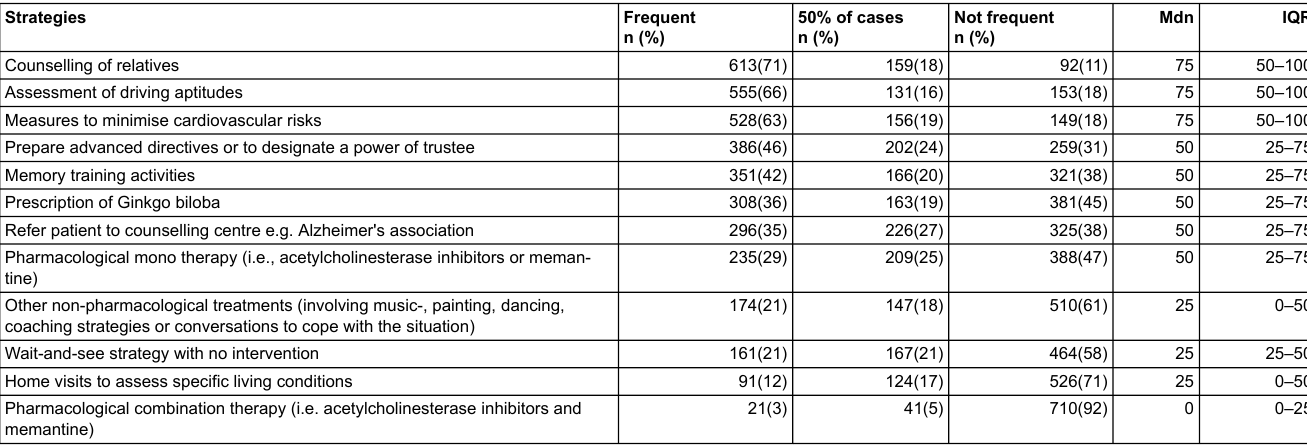
Table S4: Frequency of strategies/ interventions after a diagnosis of mild